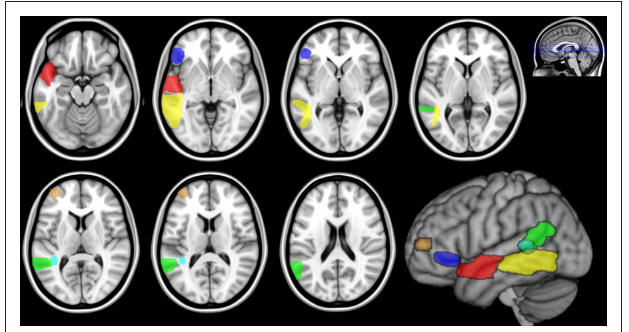
Figure 2 | regions of interest in MNi space based on the lesion- symptom mapping findings for the posterior MTg ( n ), anterior STg/ BA22 ( n ), BA47 ( n ), BA46 ( n ), STS/BA39 ( n ), and white matter underlying the STS ( n ). Slice positions are marked on a mid-sagittal view of the MNI template on the upper right